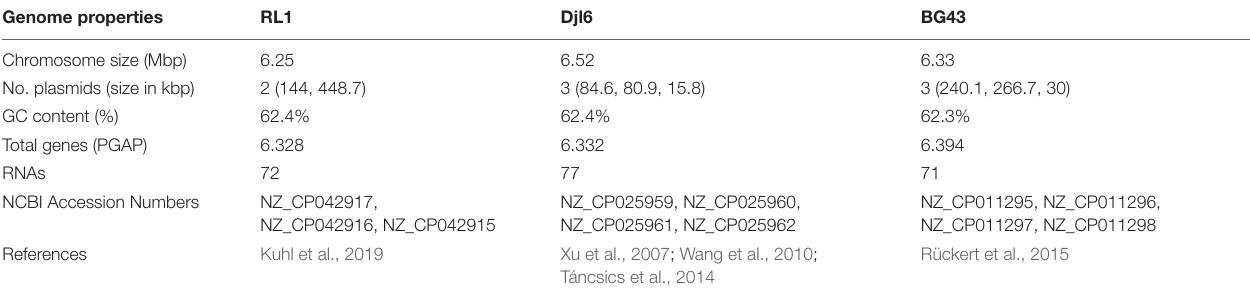
TABLE 2 | Overview of general genome properties of the isolates used in this study. Genome